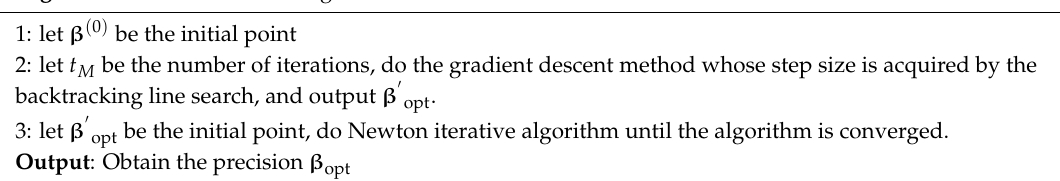
Algorithm 1 : Outline of EIO